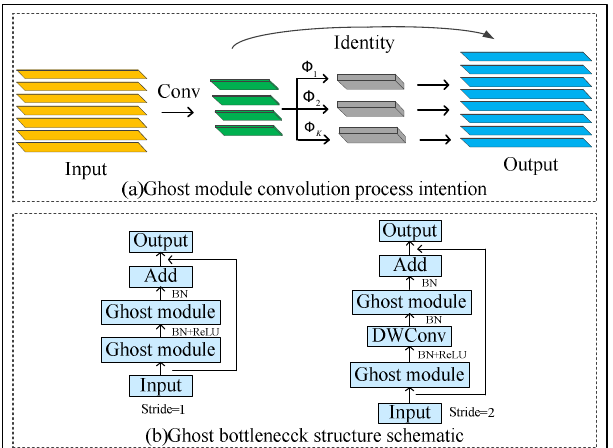
Figure 8. Ghost Net structure diagram.